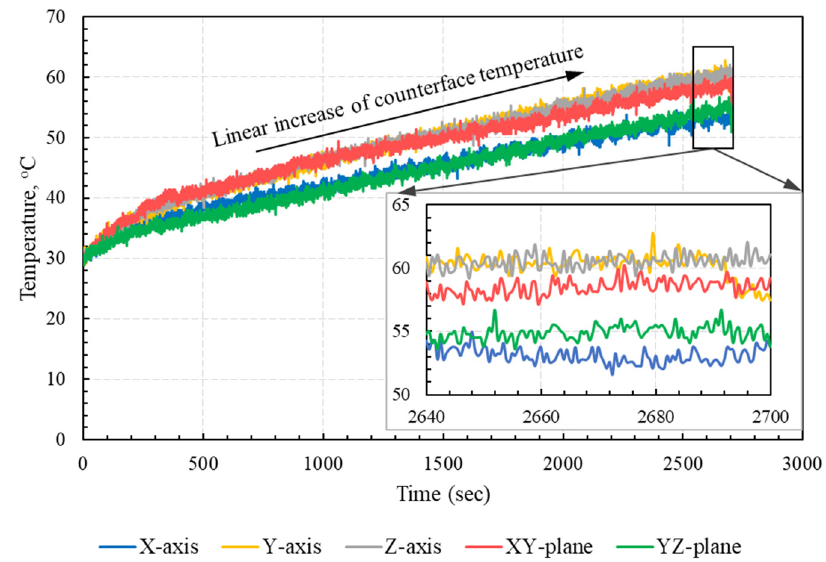
Figure 9. Approx. interface temperatures for different build orientations.